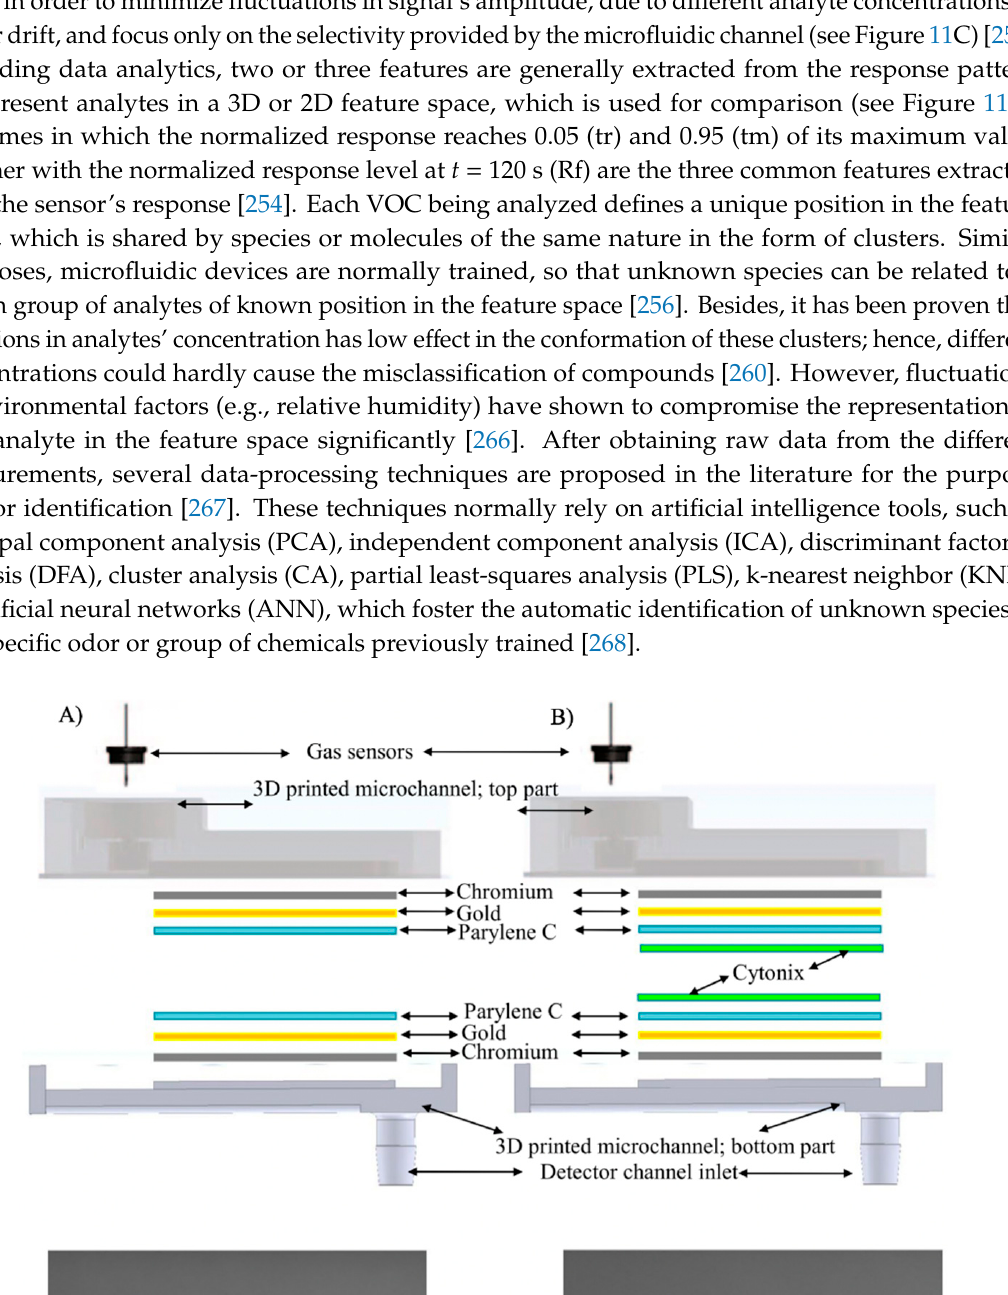
Figure 11. ( A ) Schematic diagram of the 3D-printed microfluidic device with a square-based cross- section. ( B ) Schematic representation of the diffusion and physisorption effect of gas molecules along